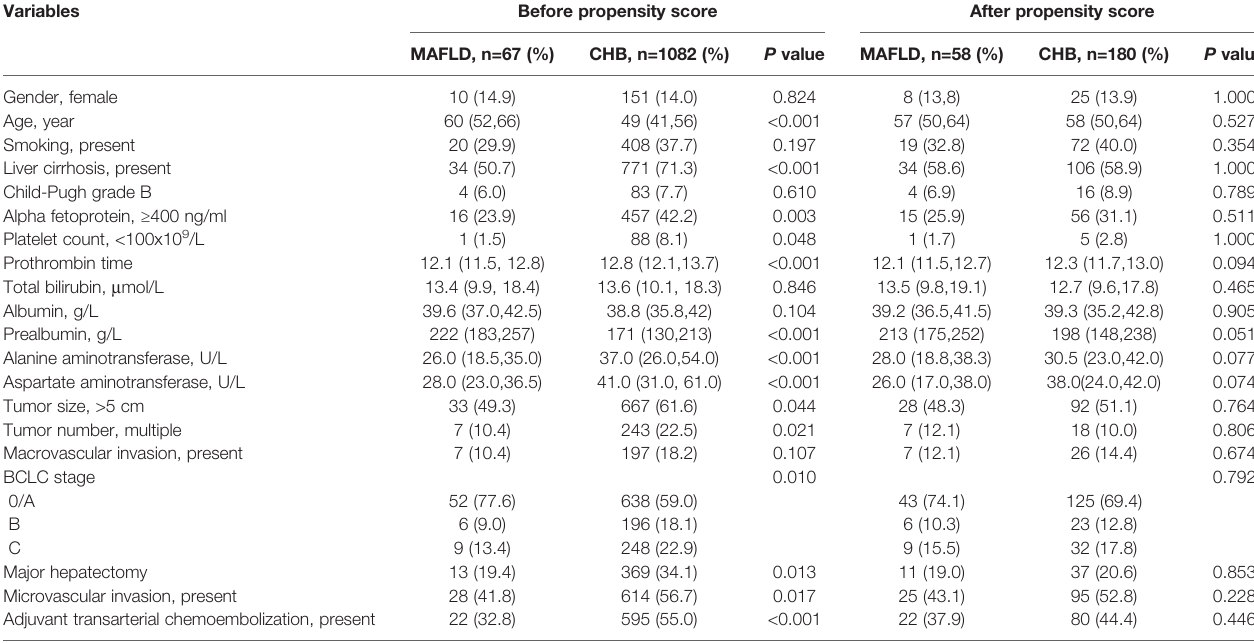
Adjuvant transarterial chemoembolization,